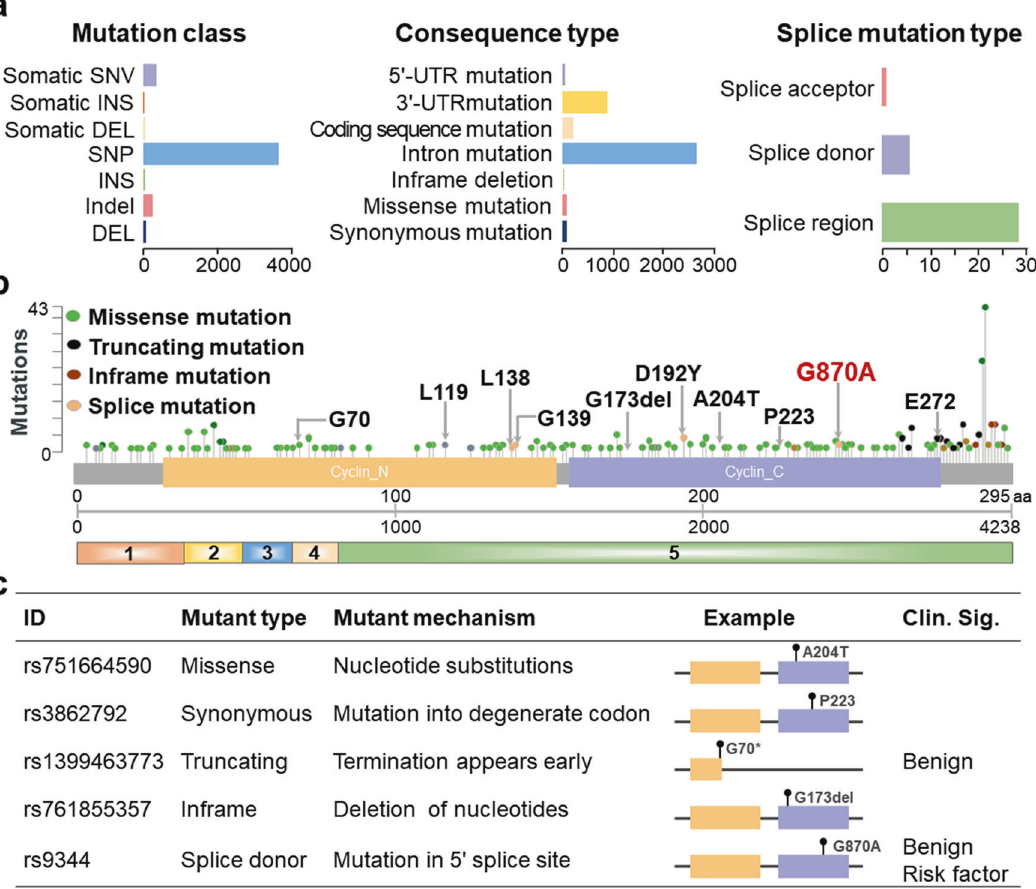
Fig. 1 General characteristic of CCND1 mutation. a The classi fi cation of CCND1 mutations is based on different mutation types. b CCND1 is composed of two domains (N-terminal of cyclin_N and C-terminal of cyclin_C). The main mutation types of CCND1 include missense mutations, truncating mutations, inframe mutations, and splice mutations. c Different mutation types are caused by different mechanisms and their clinical signi fi